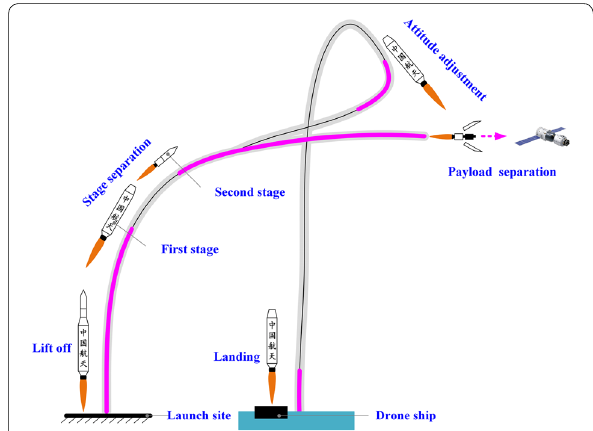
Figure 1 Overall recycling scheme of the first stage of the launched